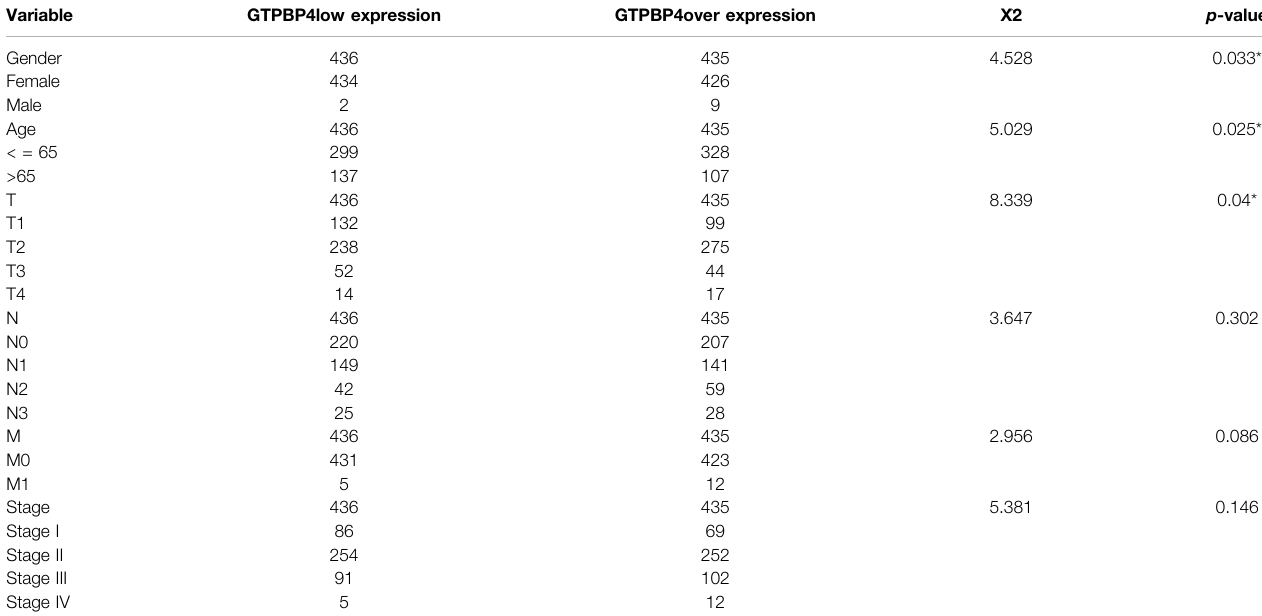
TABLE 1 | Univariate and multivariate COX